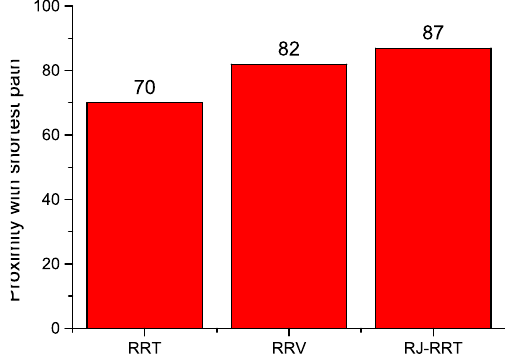
Figure 11. Approximation of three algorithms to the shortest